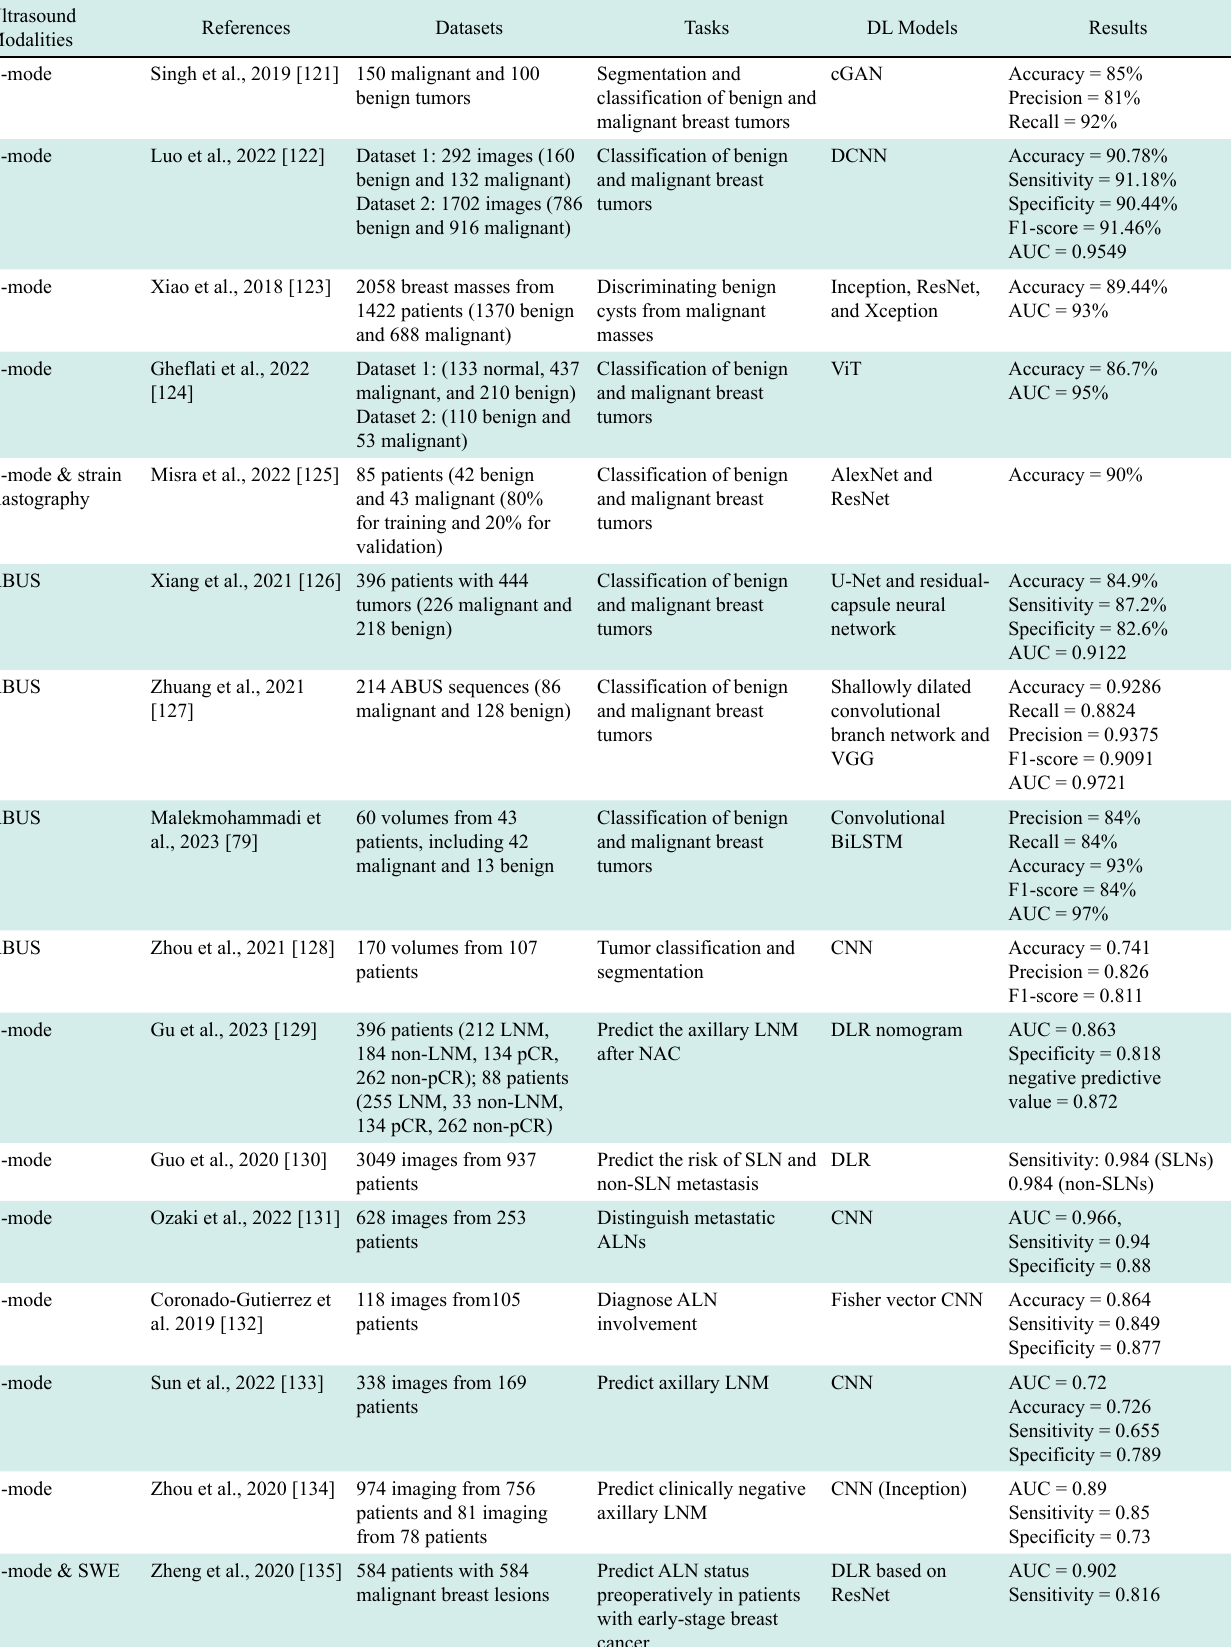
Table 3 Deep learning for breast cancer diagnosis in